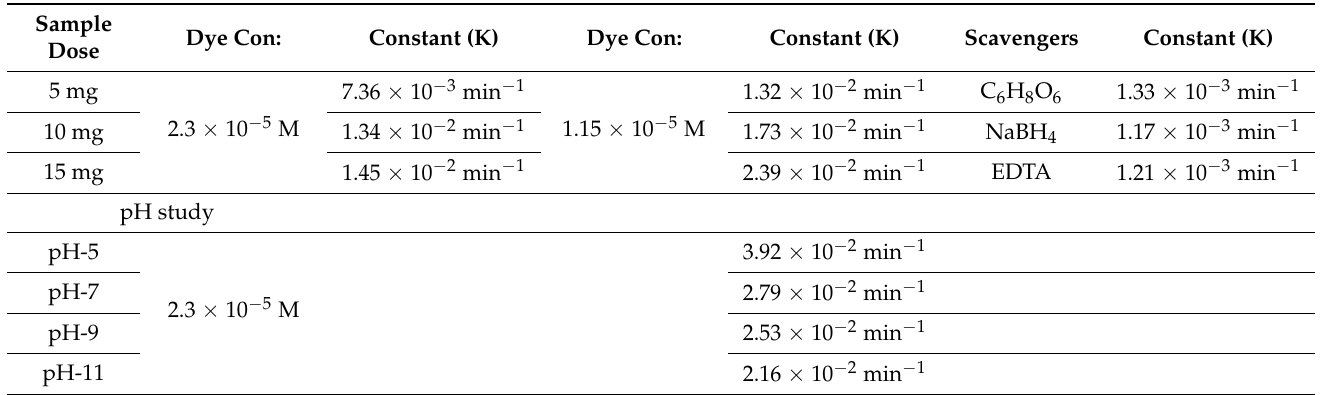
Table 1. Summarized performance evaluation of as-prepared carbon material from phalsa against the photodegradation of MB under the irradiation of UV